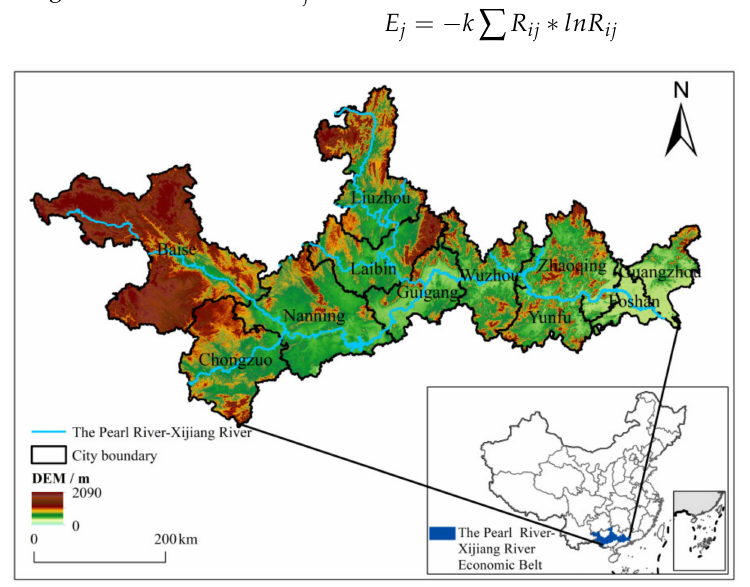
Figure 1. Location of the